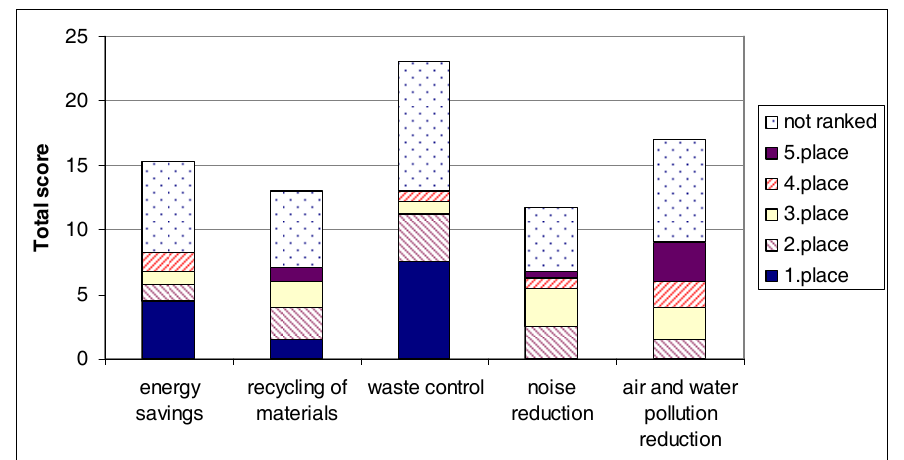
Fig 2. Contributions to total score of optional environmental issues to which the responding companies are focussing